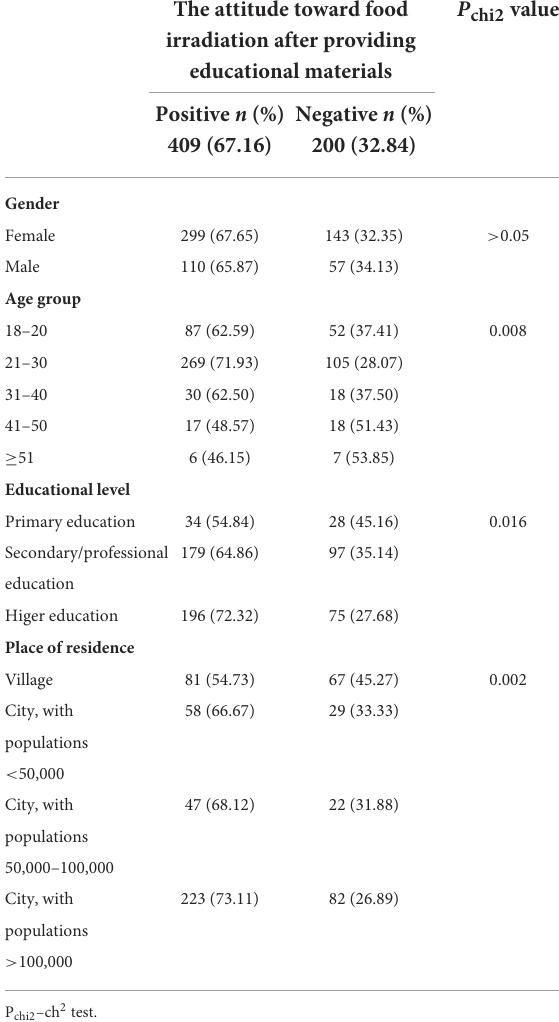
TABLE 4 The attitudes of respondent toward food irradiation after providing educational materials by sociodemographic